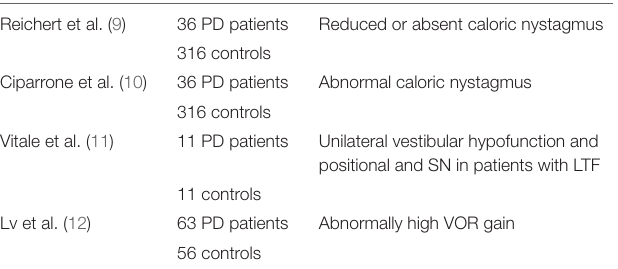
TABLE 1 | A summary of studies examining nystagmus and VOR function in PD patients. Reichert et al. (9)